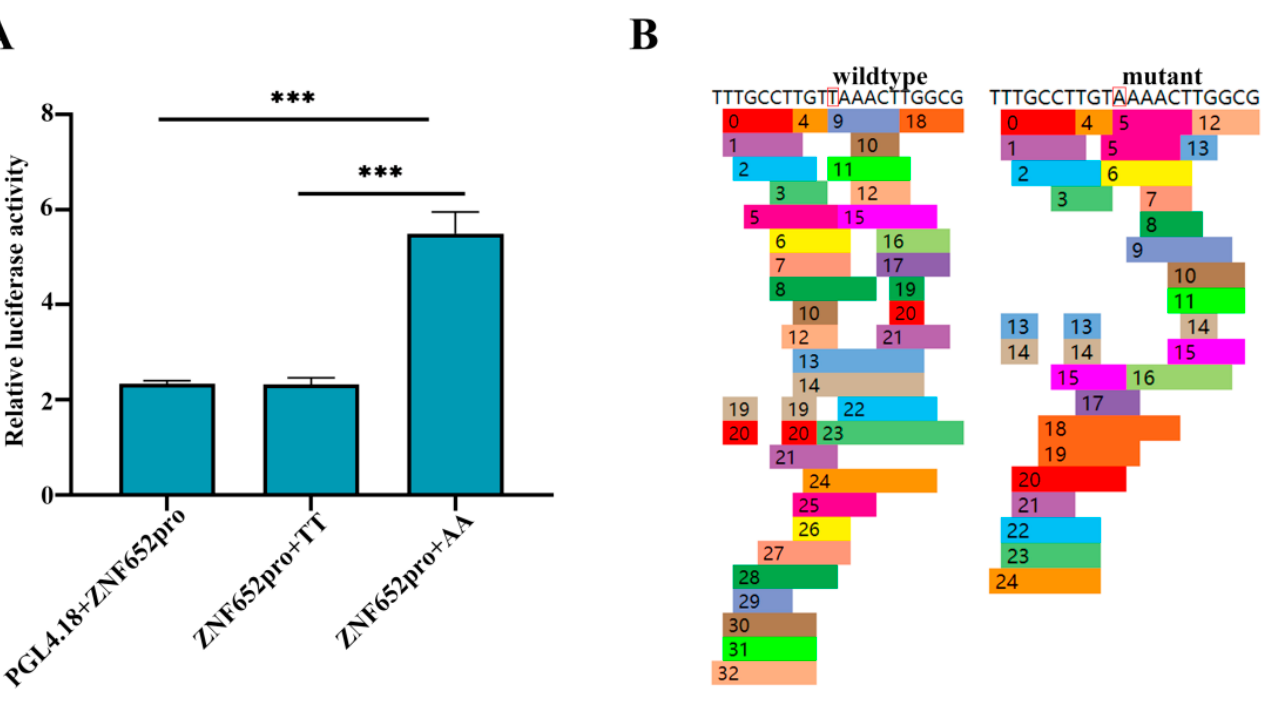
Figure 5. rs312715211 can regulate ZNF652 promoter activity. ( A ) Fluorescence intensity of dual- luciferase, ZNF652 promoter activity was significantly increased after site mutation, *** p < 0.001. ( B ) Prediction of wildtype and mutant transcription factors. All of the transcription factors were changed after rs312715211 mutated to AA.